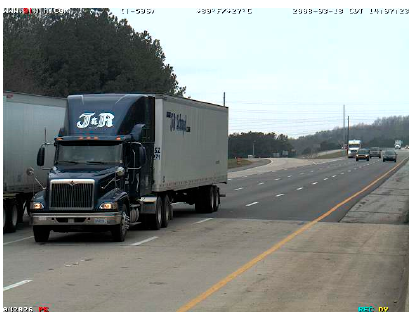
Figure 16. Photograph of trucks in Lane 2 and Lane 3.